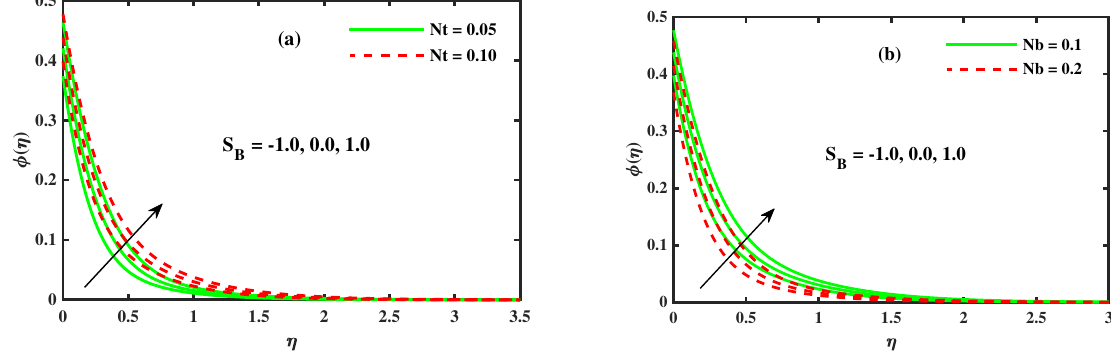
Figure 10. The impact of φ ( η ) for ( a ) thermophoresis Nt and ( b ) Brownian motion Nb . Figure 11a,b show the results of the concentration distribution with dissimilar values of the unsteady parameter σ t and solutal slip parameter L φ . The influence of unsteadiness σ t on the concentration profile φ ( η ) (see Figure 11a) is the same as the velocity profile (see Figure 4b). Figure 11b indicates the justification of the behavior of L φ on the concentration distribution. This indicates that the liquid particles have a stream conduct influenced by the solid boundary. The thickness of the solutal layer and concentration decrease radically underneath the linear permeable surface. Figure 12a,b display the impact of the activation energy parameter A e and chemical reaction parameter Ω on the nanoparticle’s concentration profile. Figure 12a emphasizes the graphical potential of activation energy A e on concentration φ ( η ) . The result depicted by the activation energy parameter A e asserted an expanding concentration distribution. The activation energy indicates a major effect in numerous interesting manners. It assumes an important job to improve the reaction phenomenon, and Figure 12b manifest that more grounded Ω leads to a decrease in the nanoparticle concentration. The clarification for this conduct is that the destructive chemical rate upgrades the mass transfer rate and results in a decrease in the nanoparticle concentration. These factors influence the dampness and temperature destruction fields, causing the obliteration of yields due to freezing, vitality generally move to the drizzly cooling tower, and so